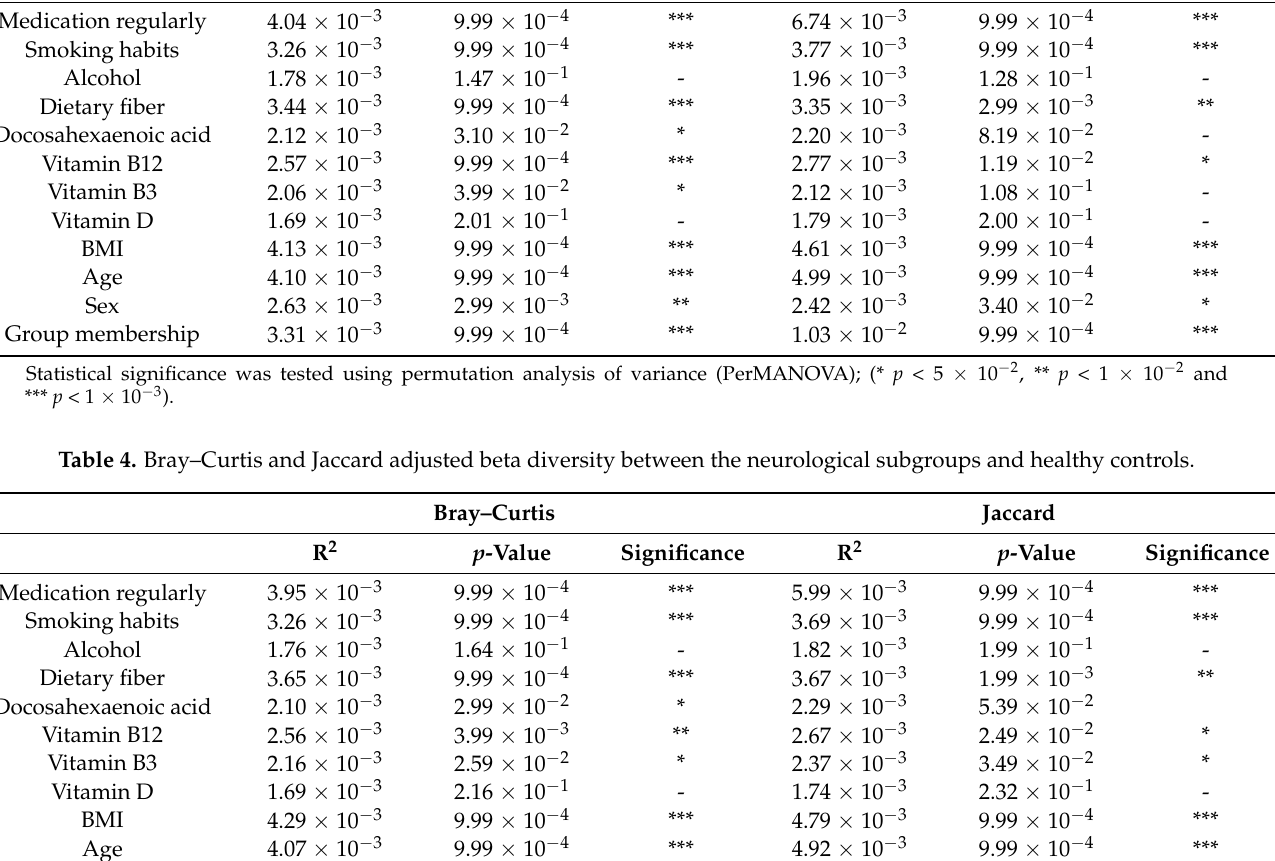
Table 3. Bray–Curtis and Jaccard adjusted beta diversity between the neurological cases and healthy controls. Bray–Curtis Jaccard R 2 p -Value Significance p -Value Significance